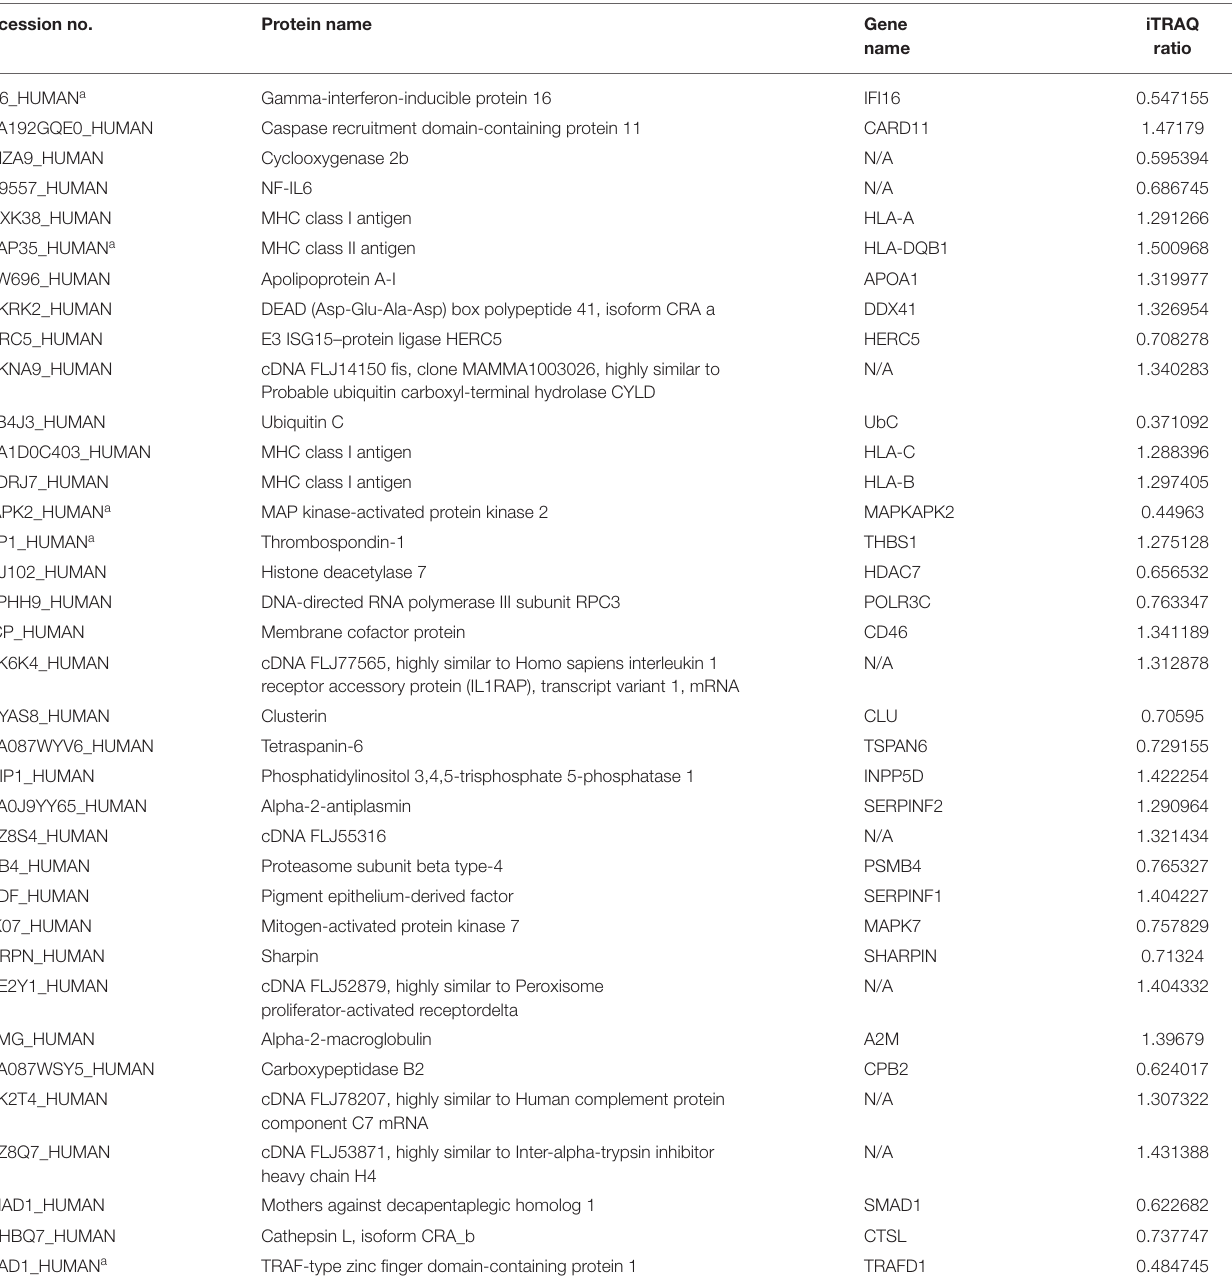
TABLE 2 | Differentially expressed proteins related with inflammation in TC0668 mut - vs. TC0668 wt -infected HeLa cells at 18h p.i. Accession